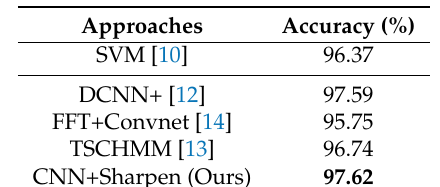
Table 6. Comparison with the state of the art approaches using UCI HAR dataset. The number in bold indicates the highest accuracy.